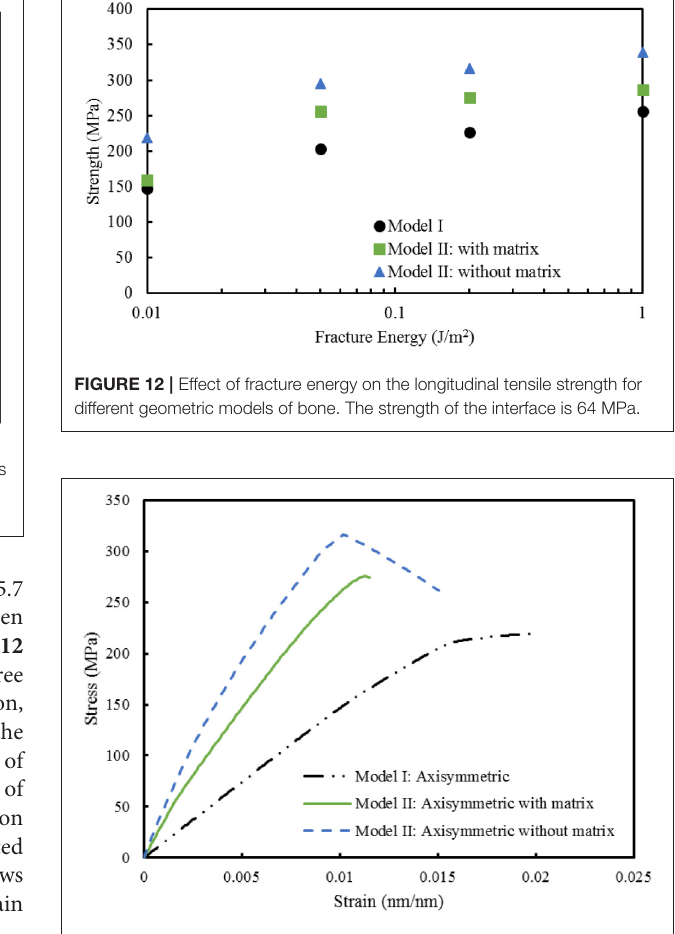
FIGURE 13 | Comparison between Model I and Model II. The strength of the interface is 64 MPa while the fracture energy is 0.2 J/m 2 .